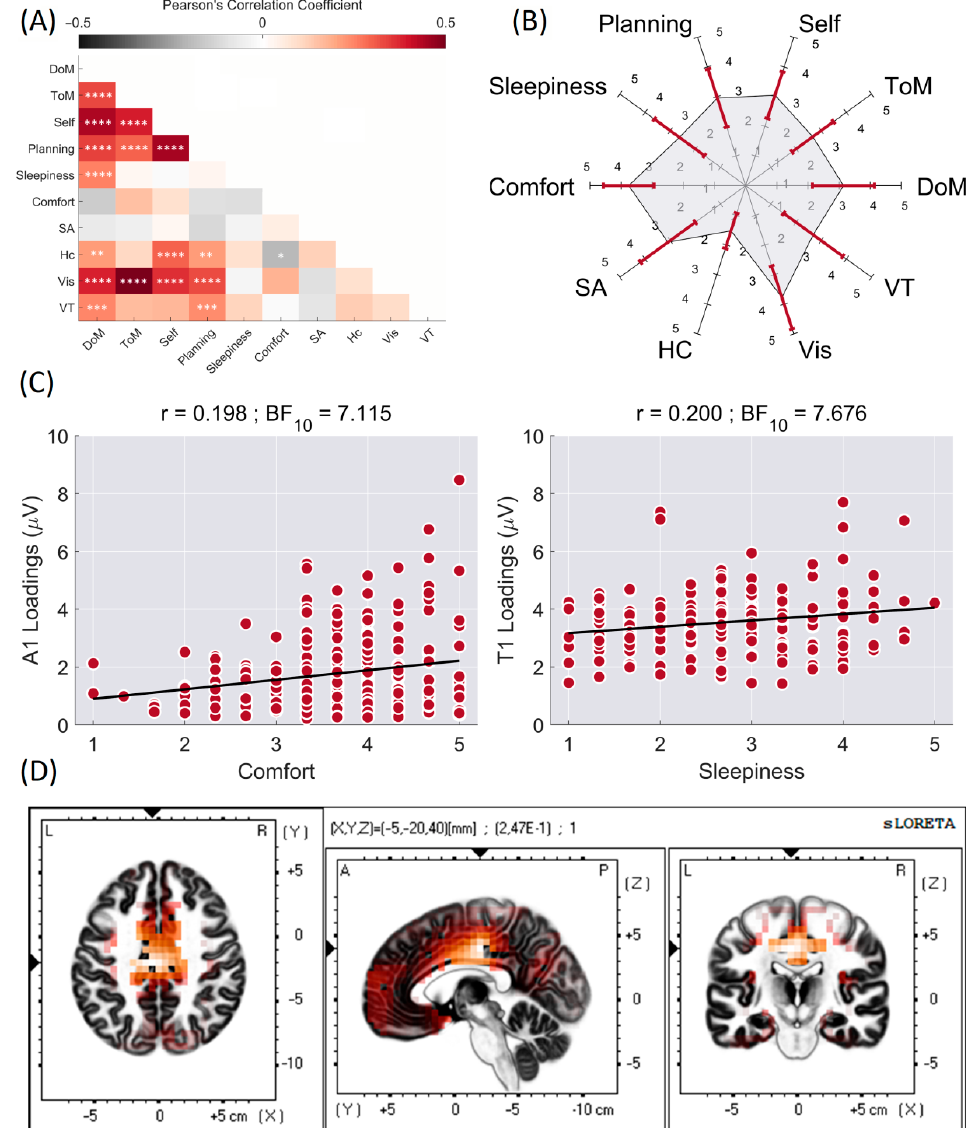
Figure 2. Intraclass Bayesian Pearson’s correlation coefficient between ARSQ domains. **** BF 10 > 100, *** 100 > BF 10 > 30, ** 30 > BF 10 > 10, and * 10 > BF 10 > 3 ( A ). Spider plot of mean scores and standard deviations (dark red lines) for each ARSQ domain ( B ). Scatter plots for significant interaction between activations and ARSQ domains ( C ). Intracortical activity estimated with sLORETA for T1 and ARSQ domain of Sleepiness ( D